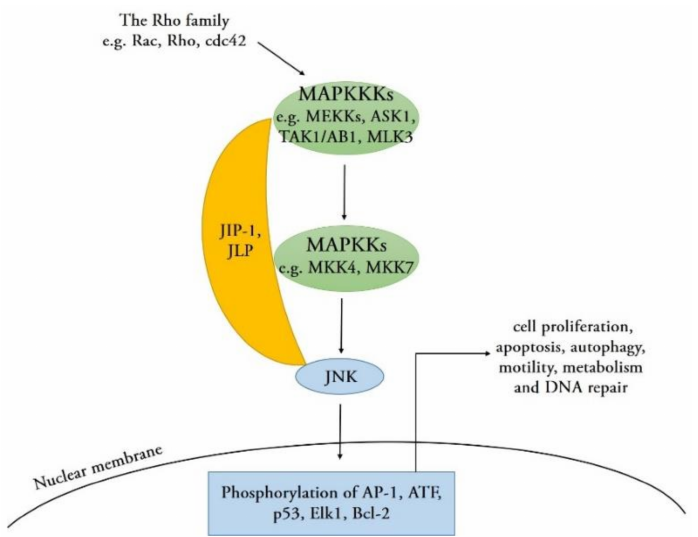
Figure 2. Mechanisms for the activation of the JNK signaling pathway. These MAPK kinase kinase (MAPKKK) proteins are activated by small GTPases (Rac, Rho, and cdc42) of the Rho family, which activate in response to various stress stimuli. JIP-1 and JLP act as scaffold proteins that bind the upstream kinases MAPKKK, MAPK kinase (MAPKK), and the MAPK (JNK) into a specific signaling module. Subsequently, JNK is activated and translocated into the nucleus and phosphorylates specific substrates, such as activator protein 1 (AP-1), activating transcription factor (ATF), p53, Elk1, and B-cell lymphoma 2 (Bcl-2). The activation of these downstream substrates regulates a wide range of cellular transcription profiles and subsequently induces numerous cellular